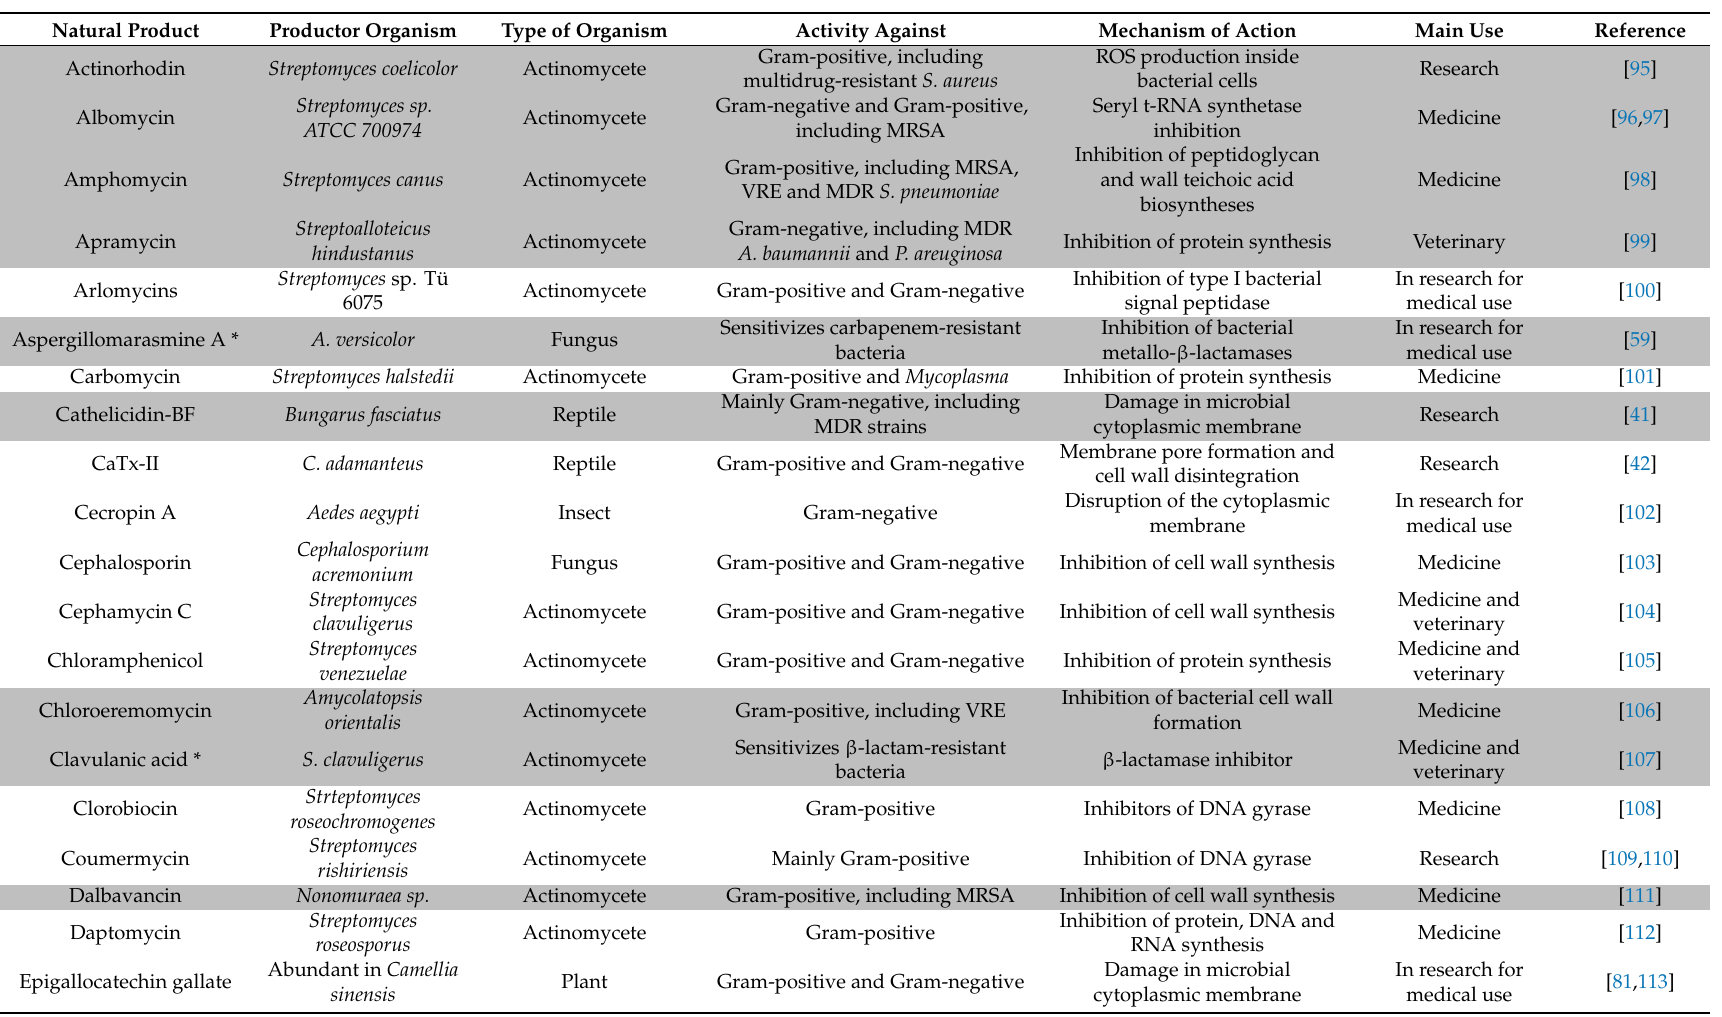
Table 1. Alphabetically ordered natural products (NPs) with their properties and capabilities. Grey shaded cells mean e ff ectiveness against AMR bacteria. Asterisk (*) means no antimicrobial activity